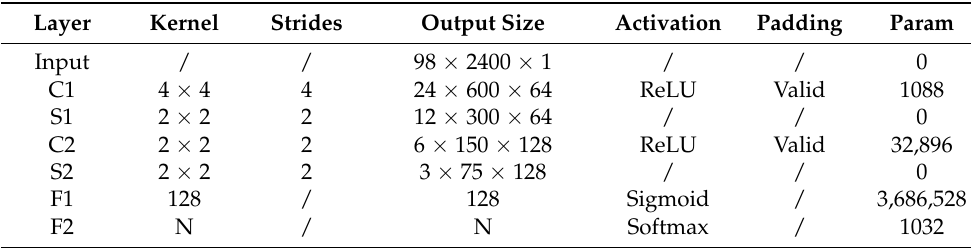
Table 2. The detailed structure of